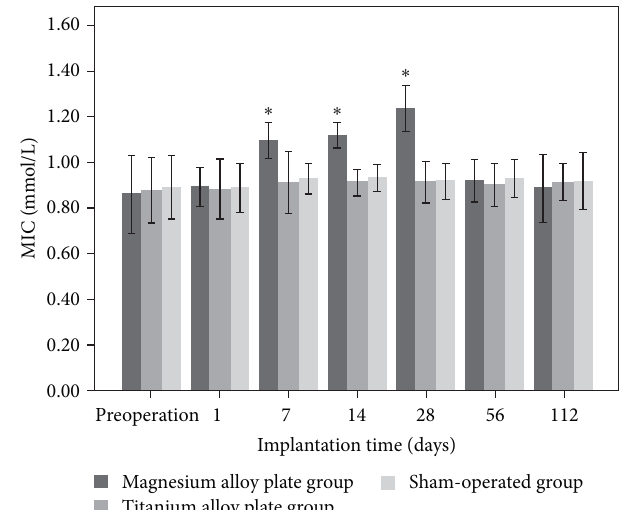
F IGURE 6: Results of MIC before and after surgery in each group ( ∗ P < 0 :